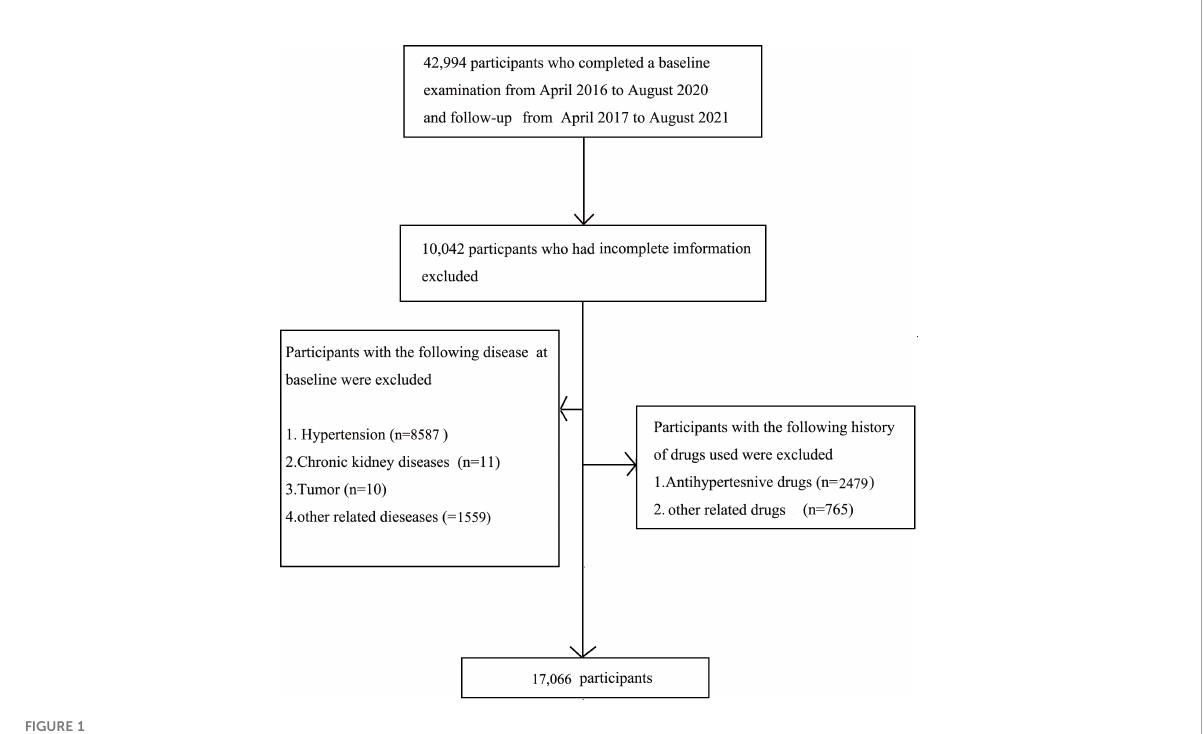
FIGURE 1 Flow chart of the selection study